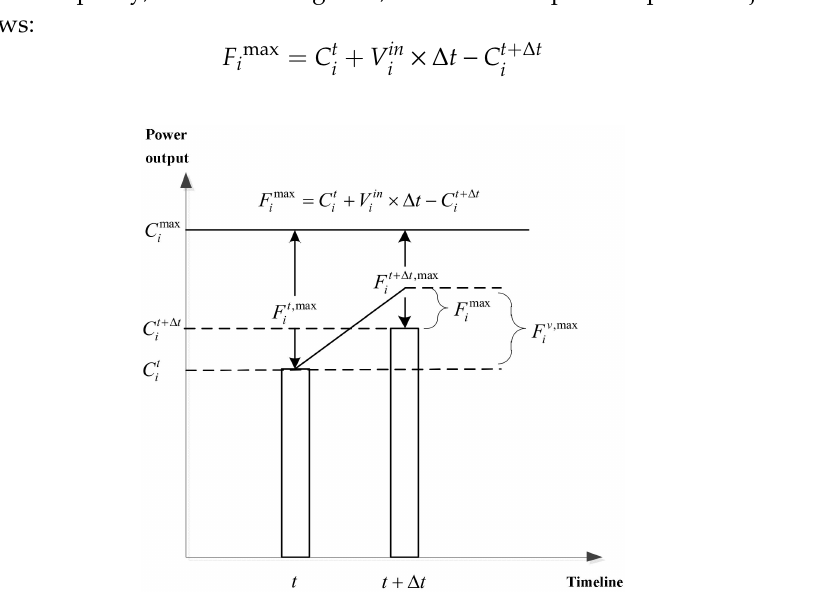
Figure 2. Maximum planned power adjustment amount with su ffi cient adjustable capacity when additional power supply is